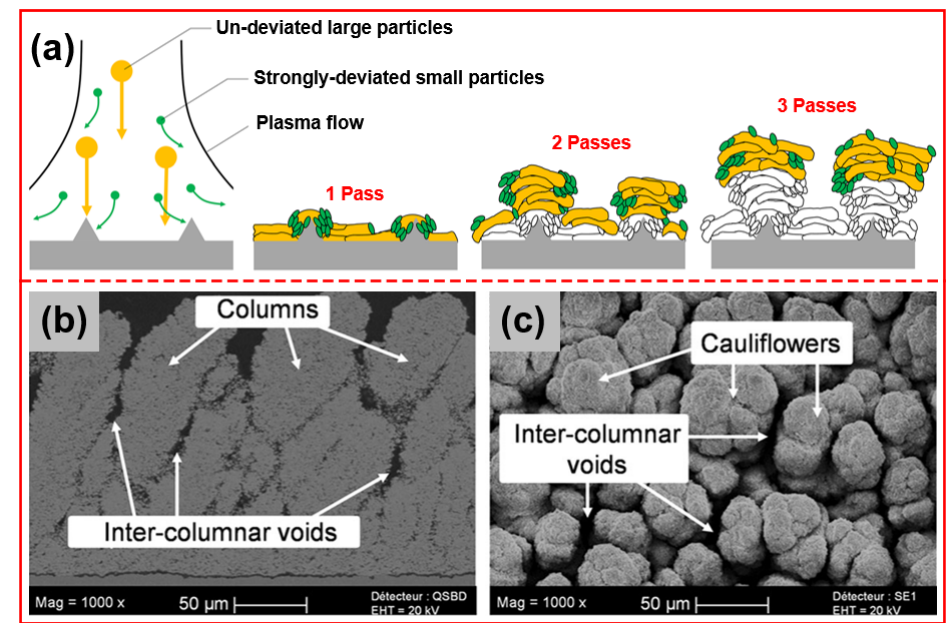
Fig. 67 Preparation process and microstructures of the SPS coating: (a) schematic of the formation of columnar structures in the SPS process and (b, c) representative columnar-structured YSZ coatings. Reproduced with permission from Ref. [385], © ASM International